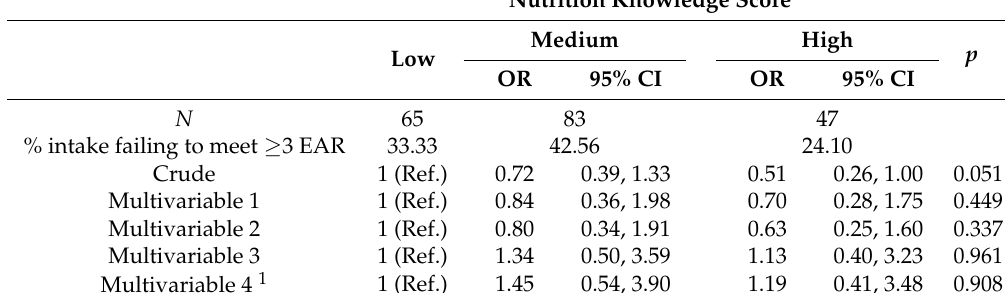
Table 3. Risk of nutrient inadequacy (failing to meet the estimated average requirements (EAR) in three or more micronutrients) associated to parental nutrition knowledge and healthy-eating attitudes score in the participants of the SENDO project.